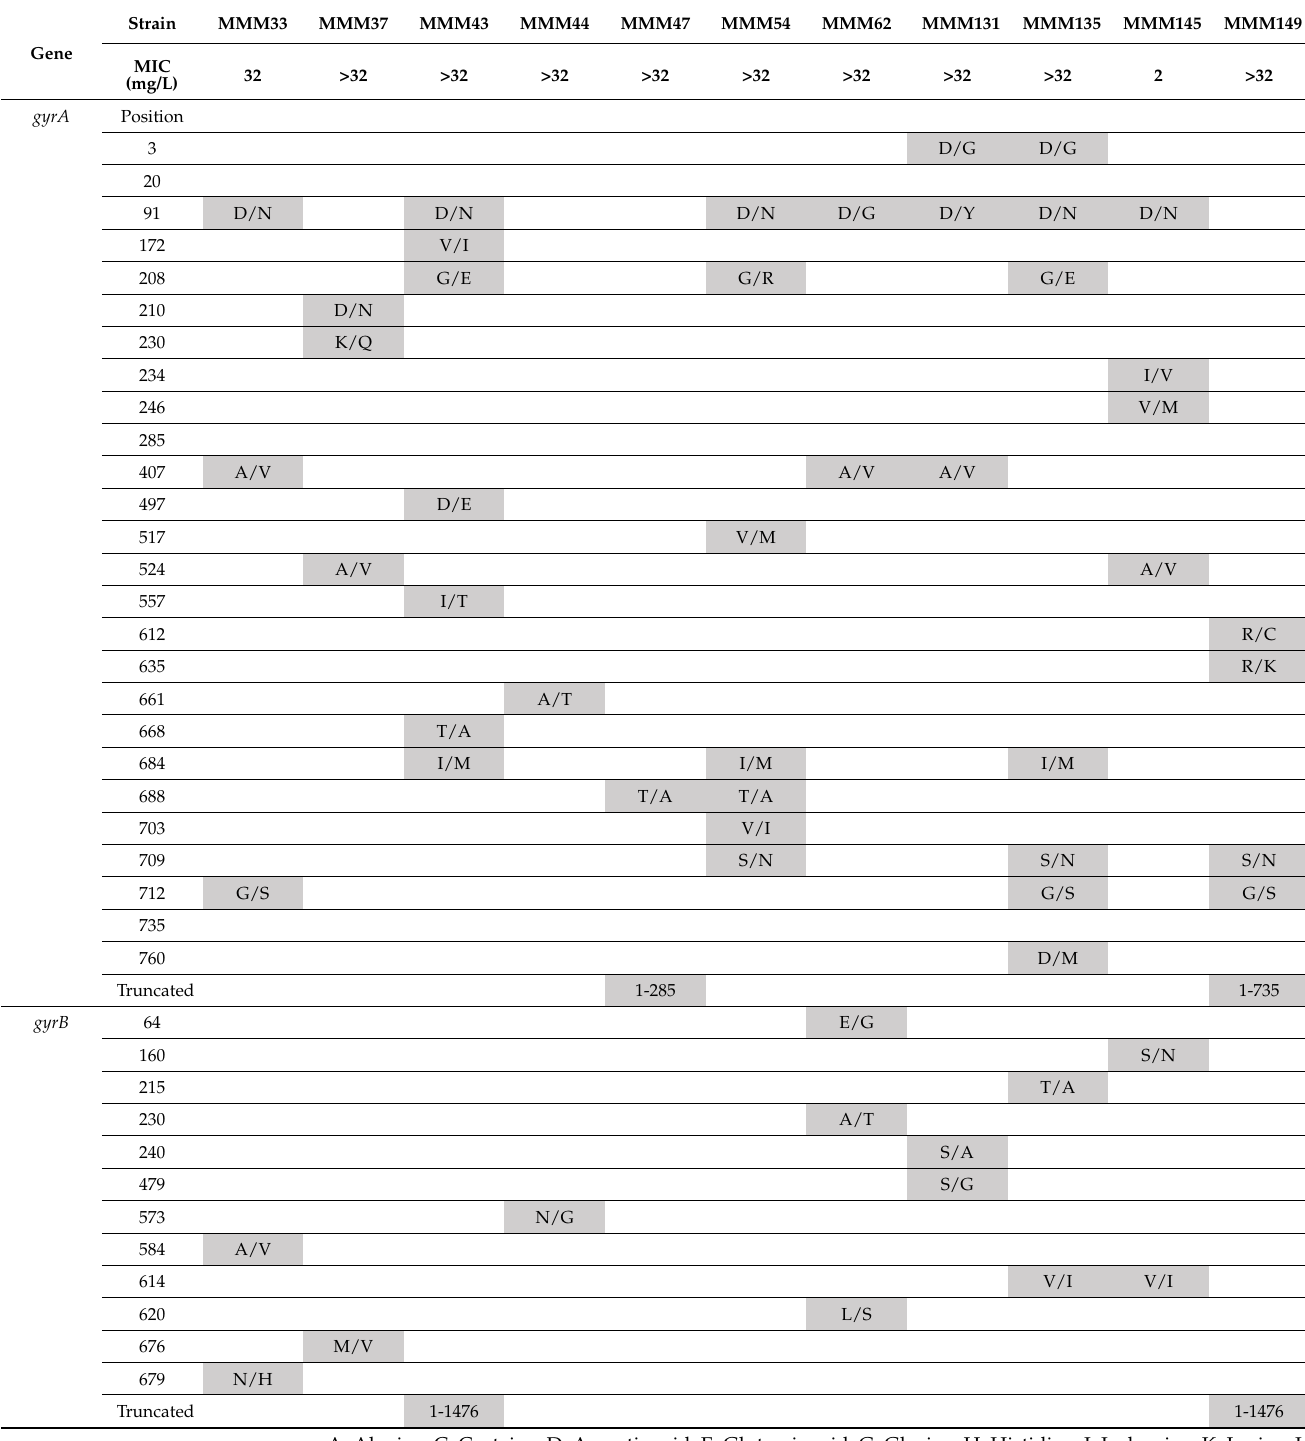
Table 5. Mutations in gyrA and gyrB that were associated with